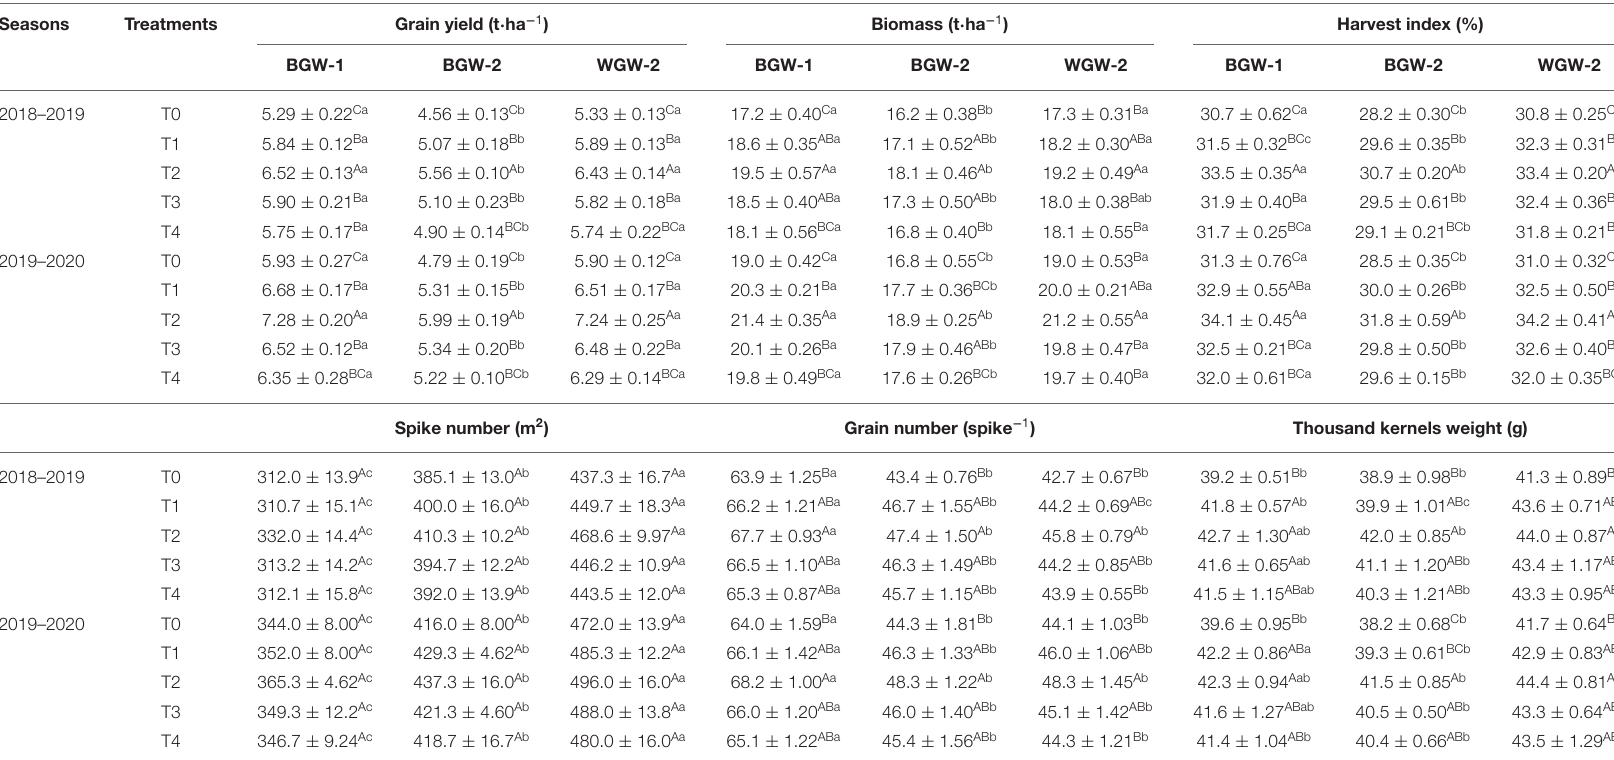
Different capital letters in the same column indicate a significant difference at α = 0.01. Different lowercase letters in the same row indicate a significant difference at α = 0.05. T0, no Se fertilizer; T1, 1,080 g · ha − 1 pure Se; T2, 2,160 g · ha − 1 pure Se; T3, 3,240 g · ha − 1 pure Se; T4, 4,320 g · ha − 1 pure Se; BGW-1, black-grained wheat genotype Xihei 88; BGW-2, black-grained wheat genotype Heidali; WGW-2, white-grained wheat cultivar Pubing